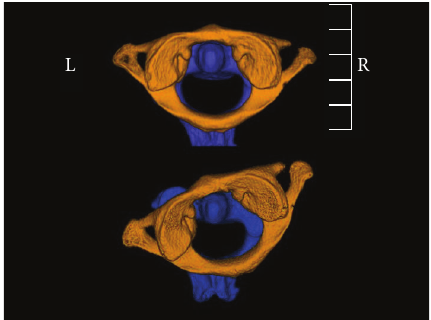
Figure 4: Cranial view after and before reduction in CT-VRT with segmentation of C1 and